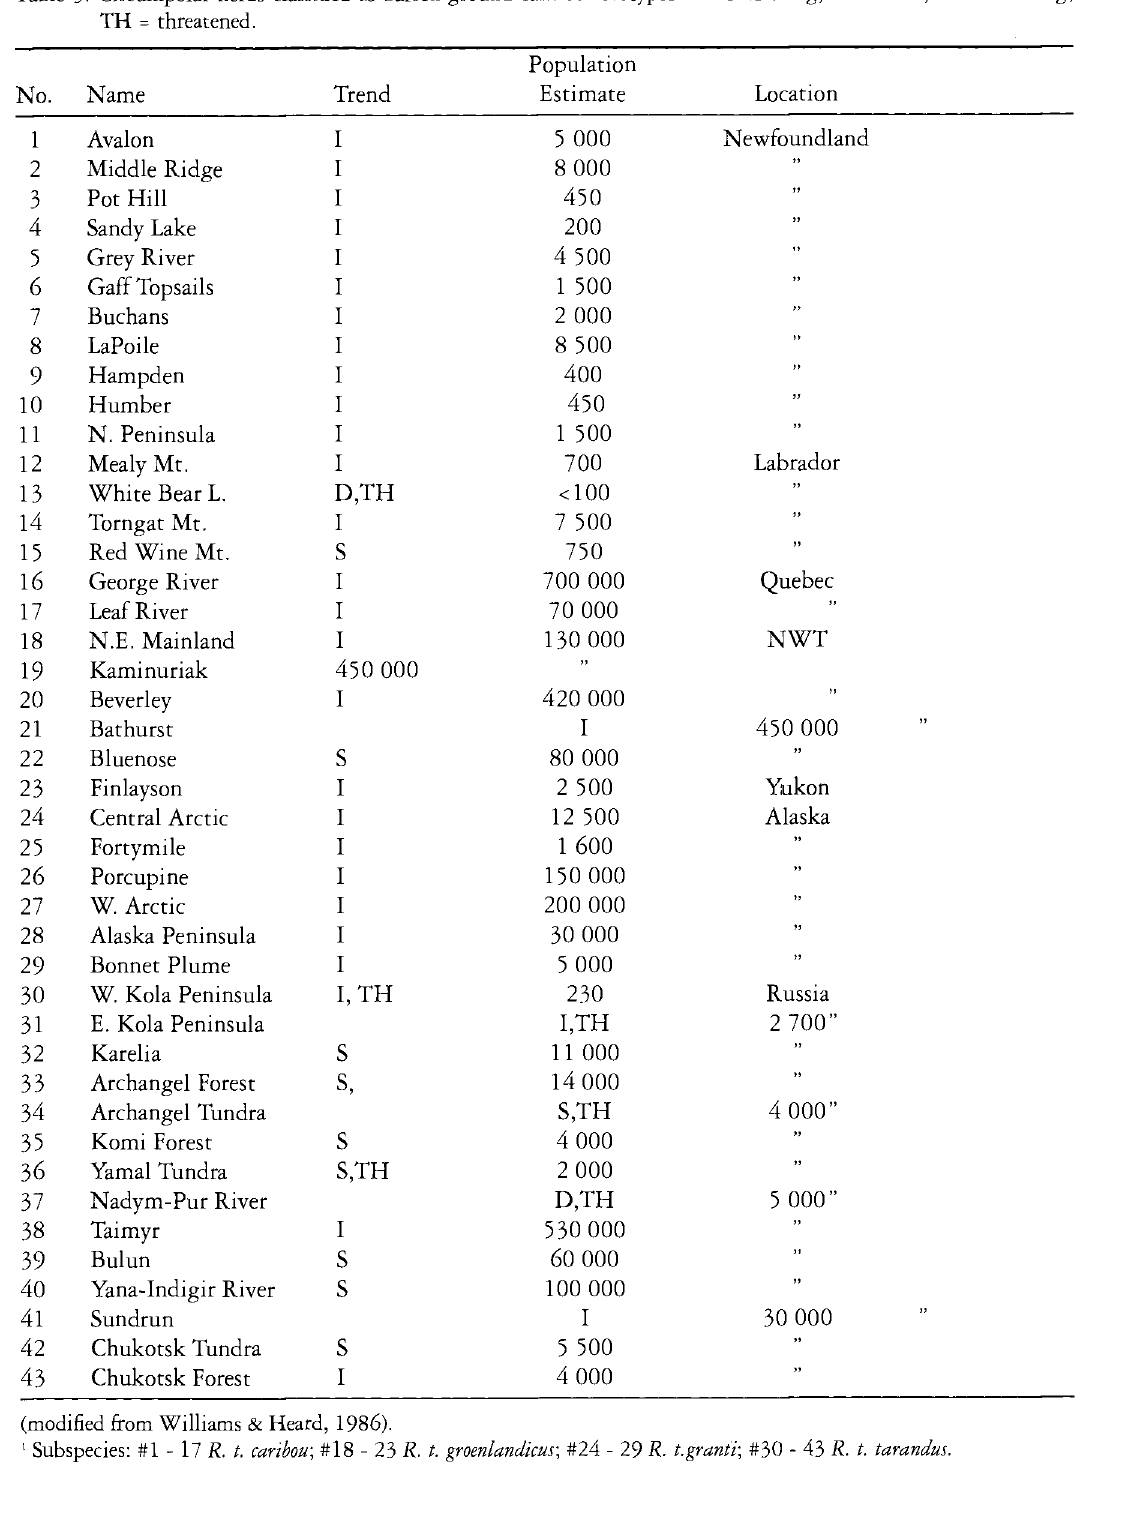
Table 3. Circumpolar herds classified as barren-ground caribou 1 ecotypes: I = increasing; S = stable; D = declining; TH = threatened.